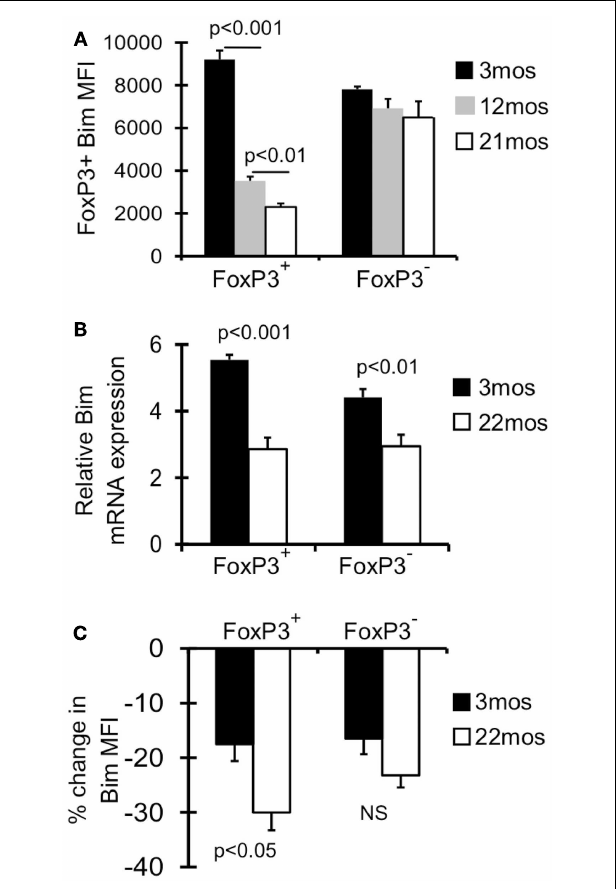
FIGURE 1 | Bim levels inT reg are progressively decreased with age . (A) Splenocytes from 3month ( n = 4), 12month ( n = 4), and 21-month-old ( n = 5) mice were stained with Abs against CD4, FoxP3, and Bim and analyzed by flow cytometry. Results show the average mean fluorescent intensity (MFI) of Bim in CD4 + FoxP3 + T cells ( ± SE).The p values represent the difference between 3 and 12months; 12 and 21months (Student’s t test). (B) FoxP3 GFP reporter mice were used to sort CD4 + FoxP3 GFP + T reg , CD4 + FoxP3 GFP − non-T reg from young (3months; n = 4) and old